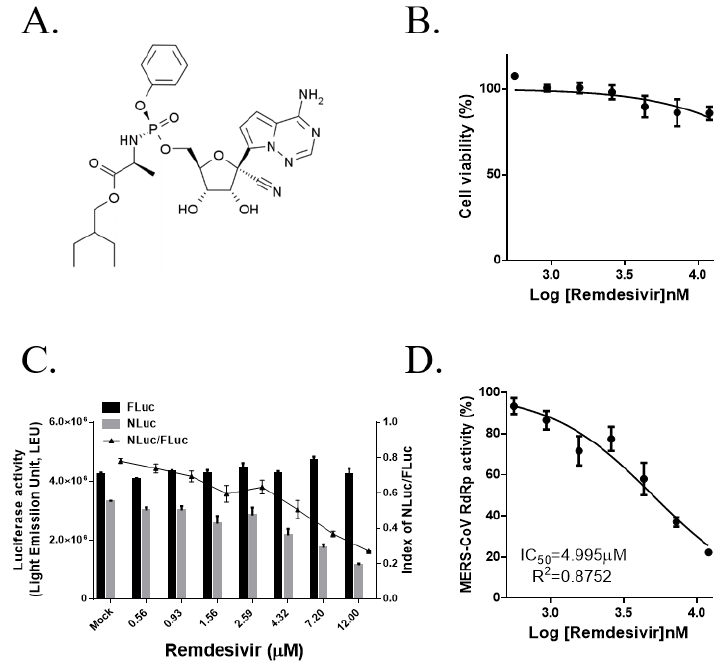
Figure 5. Effects of remdesivir on Middle East respiratory syndrome coronavirus RNA-dependent RNA polymerase activity in the cell-based reporter assay system. ( A ) Chemical structure of remdesivir. ( B ) The viability of remdesivir-treated HEK293T cells was determined using the MTS assay after treatment with the indicated concentrations for 18 h. ( C ) HEK293T cells were transiently transfected with p( + )FLuc-( − )UTR-NLuc and pN-termFlag-nsp12, and, after 6 h, cells were treated with remdesivir at the indicated concentrations for 18 h. FLuc and NLuc activities were measured and the NLuc / FLuc ratio were determined. ( D ) The IC 50 value of remdesivir was calculated via non-linear regression analysis. The data, which are representative of at least three independent experiments, are presented as the mean ±